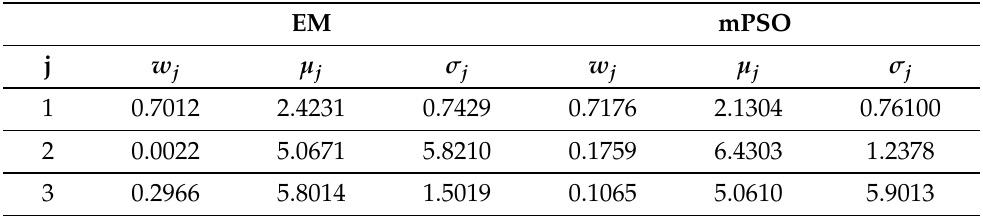
Table 1. Output GMM from EM and mPSO methods.